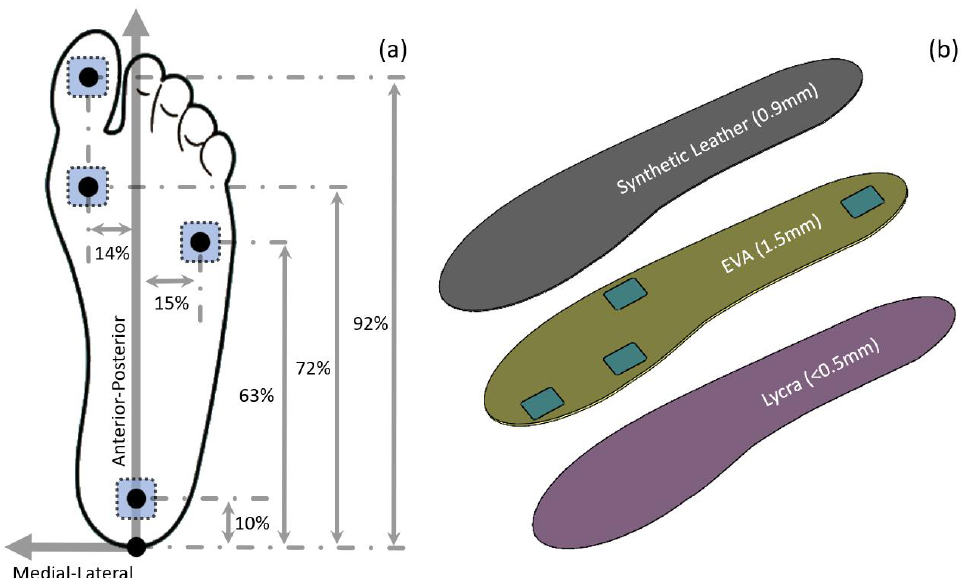
Figure 1. ( a ) Location of the sensors as a percentage of foot length and width. ( b ) Layered sensorised insole construction. The black dots represent the geometrical centre of the sensors. insole construction. The black dots represent the geometrical centre of the